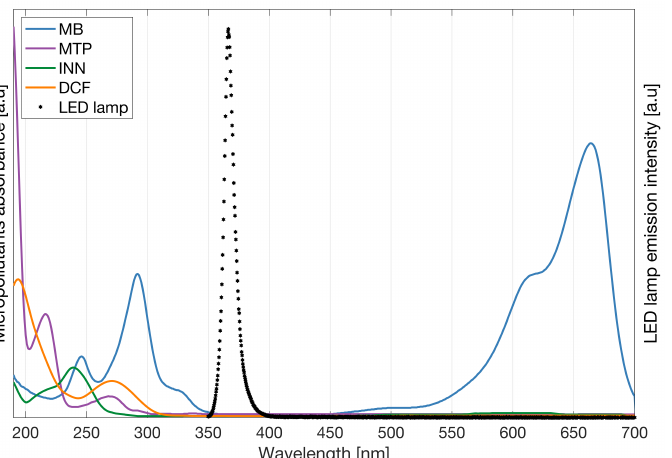
Figure A2. Combined spectrum of the micropollutants absorbance and LED lamp emission intensity. To protect the micropollutants from any reaction with the ambient light, the dead- end filtration and degradation experiments were performed inside a cupboard, and all of the solutions were stored in opaque bottles with the extra protection of aluminum paper around